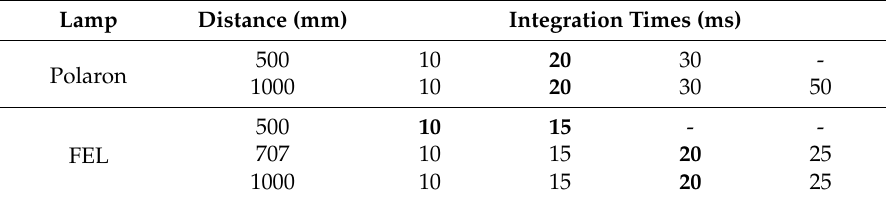
Figure 3. The radiance calibration setup. The lamp is placed on an optical rail to a known distance from a reflectance panel. The FPI camera is viewing the panel from 45° angle. Stray light is blocked by light baffles (additional baffles were placed after taking this image). Table 1. Different image data sets used in radiance calibration. Distance is lamp distance from the reference panel. Data marked normal font were used in calculating new conversion factors for radiance, data marked with bold were used as independent test cases for evaluating the radiance accuracy.